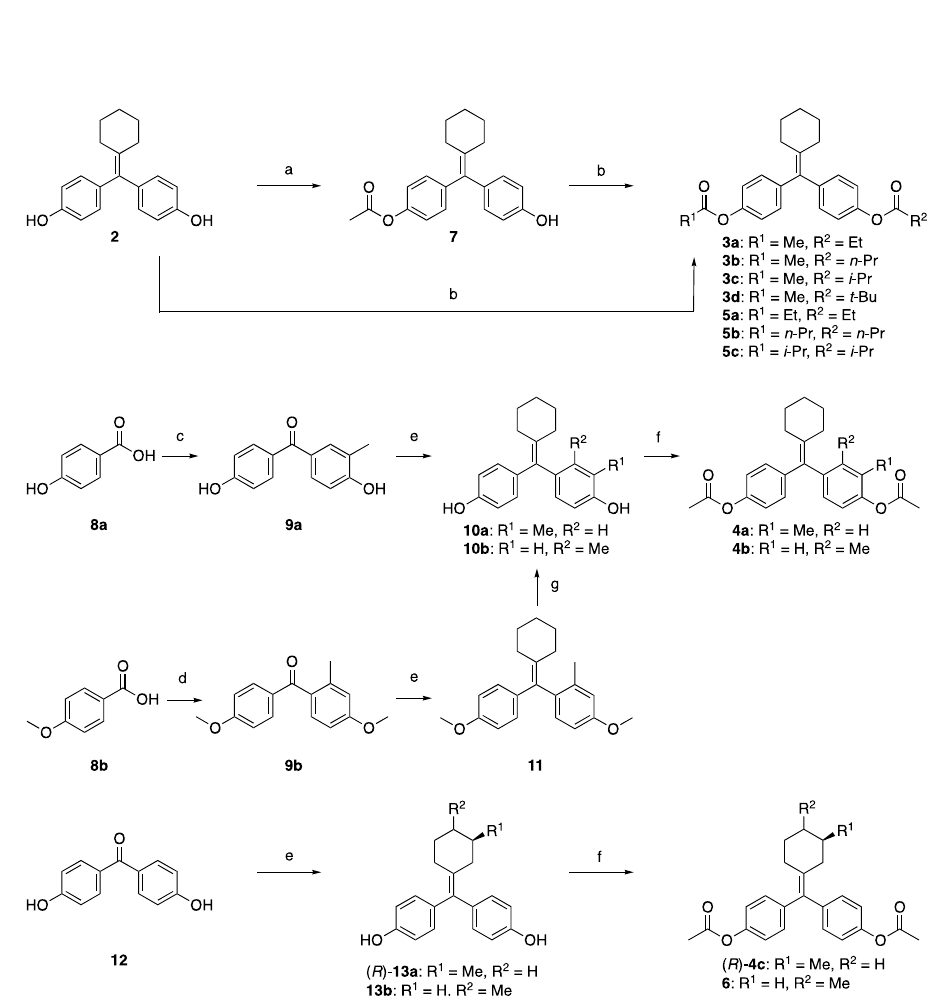
Figure 2. Reagents and conditions: ( a ) acetic anhydride (1.0 eq.), pyridine, DCM, 52% b.r.s.m.; ( b ) acid chlorides, pyridine, DCM or DCE, 80–87%; ( c ) o -cresol, ZnCl 2 , POCl 3 , 70 °C, 69%; ( d ) SOCl 2 , reflux, then m -cresol, AlCl 3 , DCM, 0 °C to rt, 70%; ( e ) cyclohexanones, Zn, TiCl 4 , THF, reflux, 75–91%; ( f ) acetic anhydride, pyridine, DCM, 75–95%; ( g )